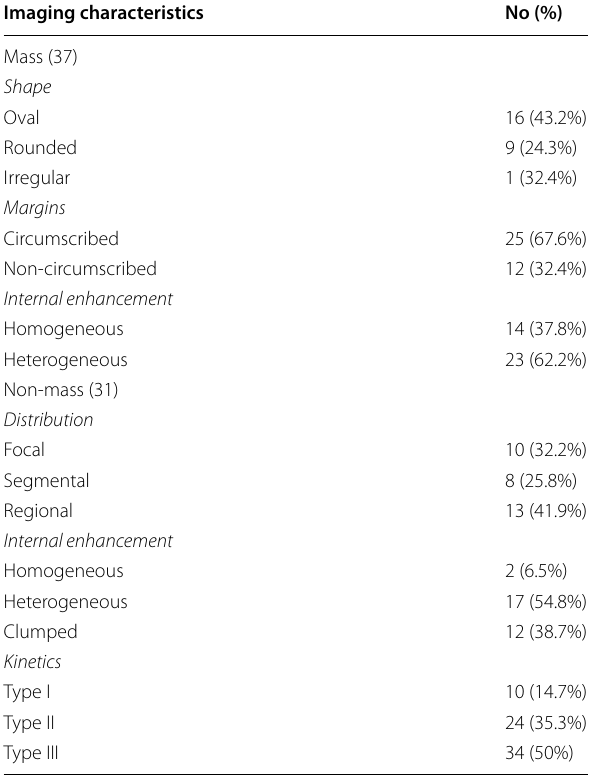
Table 3 MRI imaging findings of high‑risk breast lesions Imaging